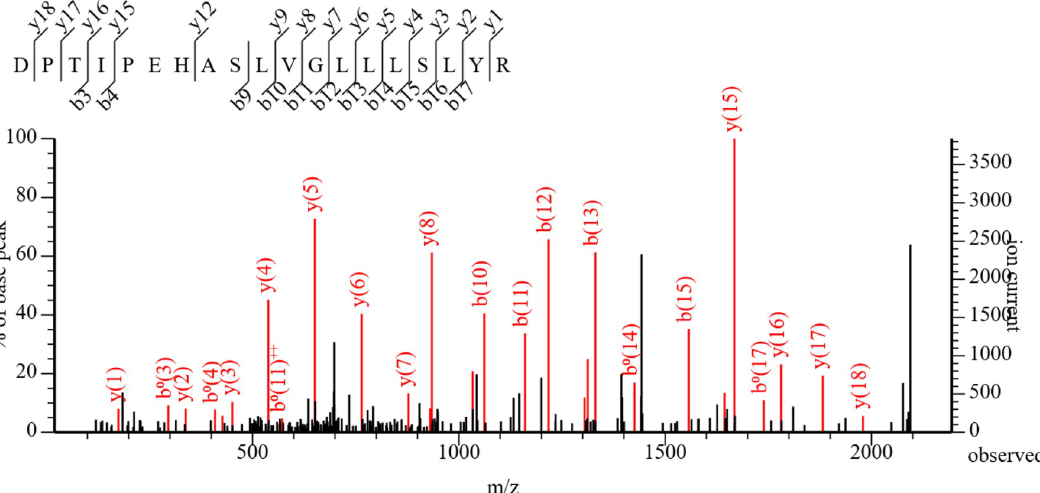
Fig 7. Peptide view. MS/MS fragmentation of peptide DPTIPEHASLVGLLLSYLYR derived from N protein corresponding to E. Raccoon RABV variant. The position and mass of various N- and C- terminal fragments (denoted by b n and y n , respectively) are indicated in the